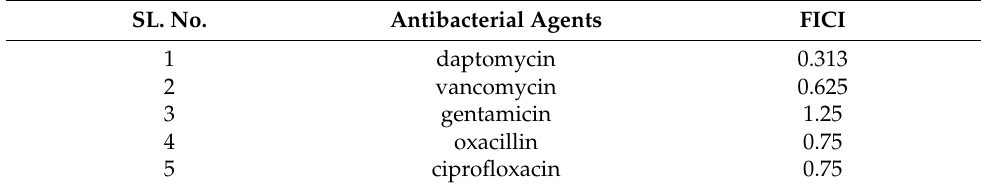
Table 3. Synergy analysis of C18 with clinical antibacterial agents. SL.